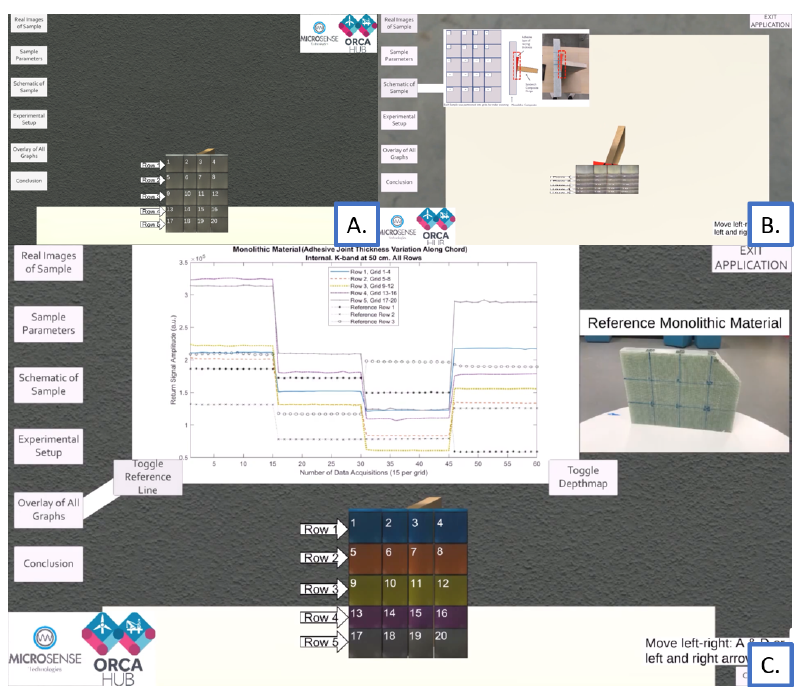
Figure 8. ( A ). Overview of AID interface. Buttons on the left allow specific information to be overlaid, with a 3D model of the asset in the middle. ( B ). Visualisation of the sample defect in the AID. The defect is highlighted in red. ( C ). Visualisation of all return signal graphs in the AID. Row colours in the graph match up to the WT 3D